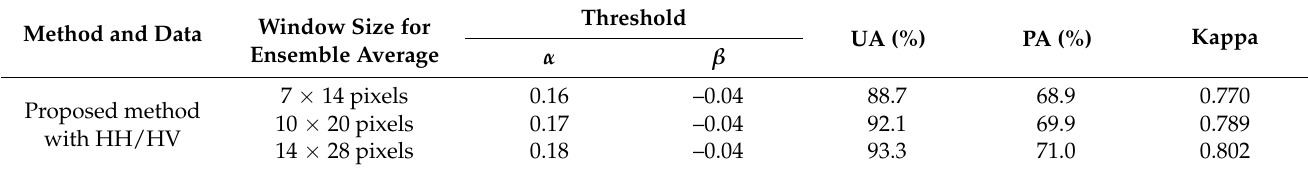
Table 5. Deforestation detection performance at Rio